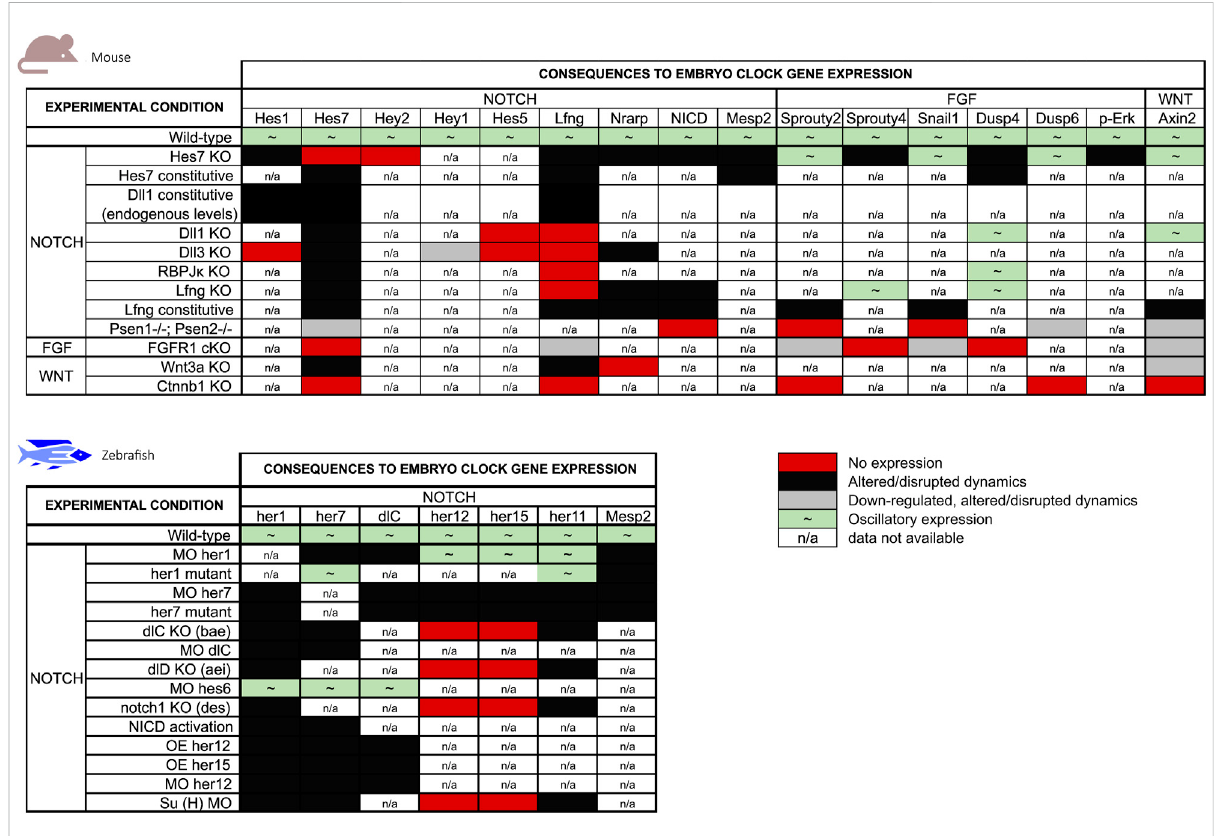
FIGURE 4 Summary of the effects of genetic manipulation on mouse and zebra fi sh EC gene expression. EC genes were grouped by the main signalling pathways they are associated with.